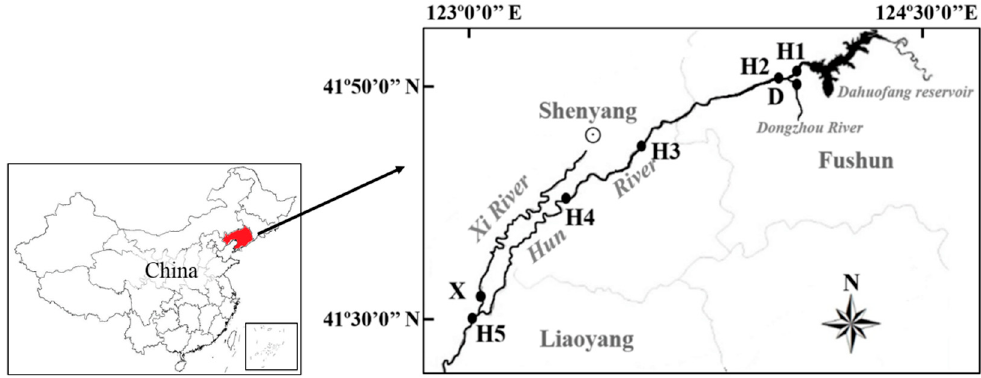
Figure 1. Locations of the sampling sites.